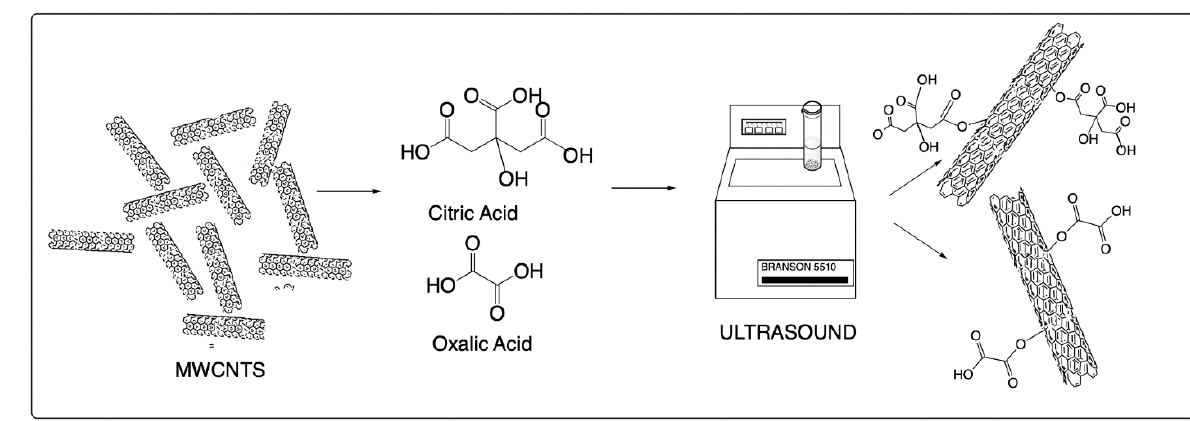
Figure 1. Ultrasound-assisted multiple-wall carbon nanotube (MWCNT) modification process with citric acid and oxalic acid.